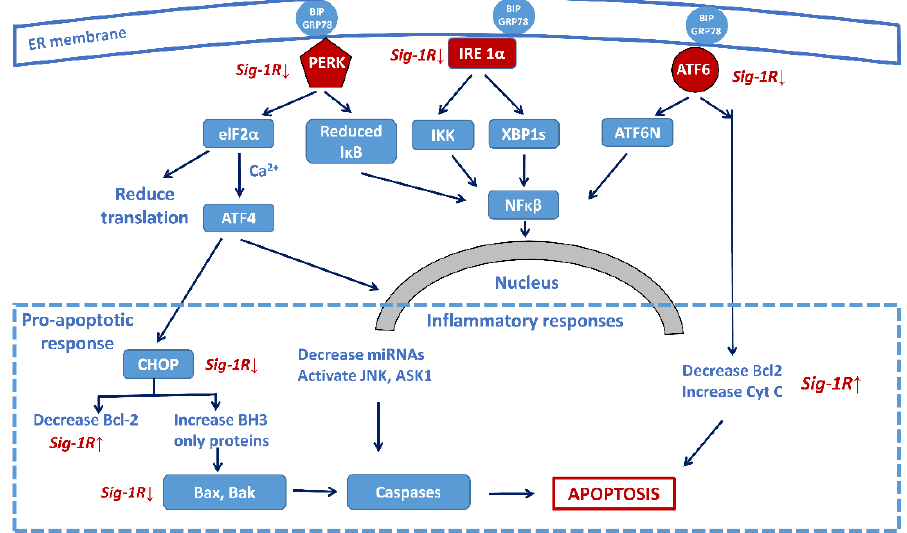
Figure 4. Sig-1R regulation of the three main signaling pathways of ER stress-activated unfolded protein response (UPR) focusing on the central role of the transcription factor NF- κ B. Sig-1R activation increases cell survival by the attenuation of the activity of the three sensors (PERK, IRE-1 α , and ATF6) and decreasing the pro-apoptotic responses, as well as increasing the anti-apoptotic Bcl-2 activity. (Abbreviations: PERK: protein kinase RNA-like ER-kinase; IRE1 α : inositol requiring enzyme 1 α